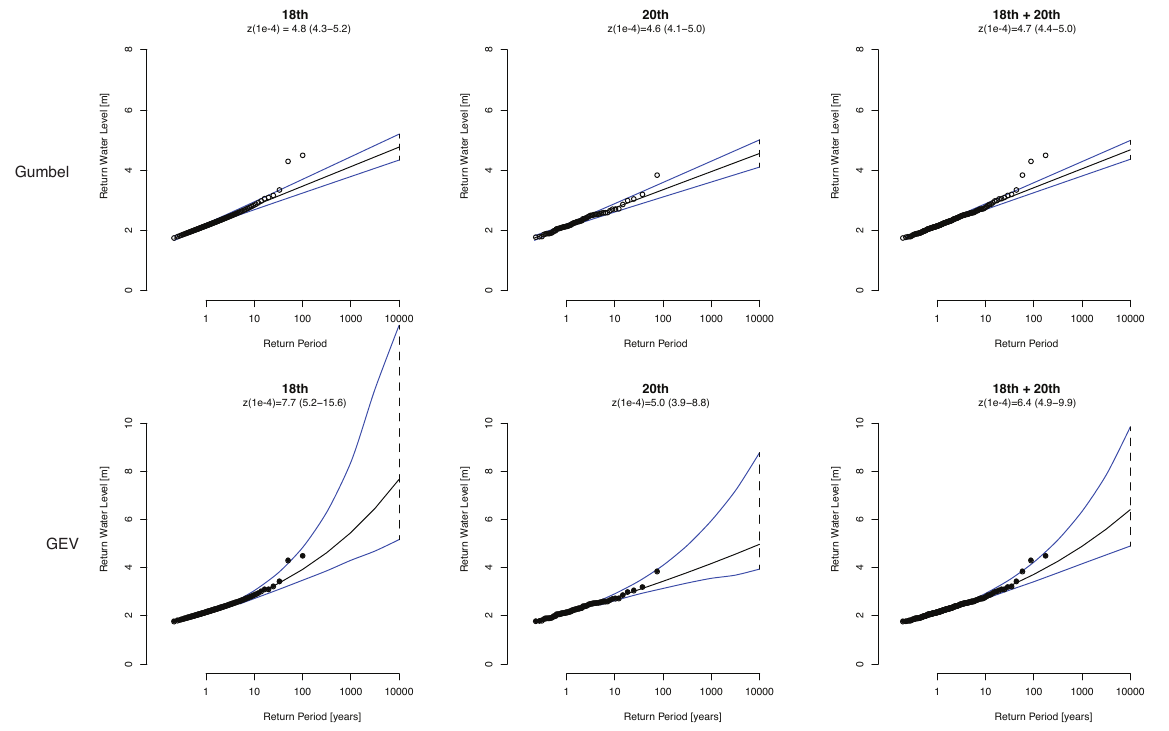
Fig. 6. Return level plot for the location Egmond for the period 1932–2010, 1700–1800 and the combined fit. The upper row represents a fit using the Gumbel distribution (Generalised Extreme Value distribution with ξ = 0). The lower row represents a fit using the Generalised Extreme Value distribution using a free ξ parameter. The circles represent observed (1932–2010) and estimated (1700–1800) water levels plotted against the observed return period. The black solid line represents the fitted return water level as a function of the return period. The outer blue lines follow the lower and upper bound of the 95% confidence interval. The vertical dashed line marks the confidence interval for the 1 / 10000 per year water level.